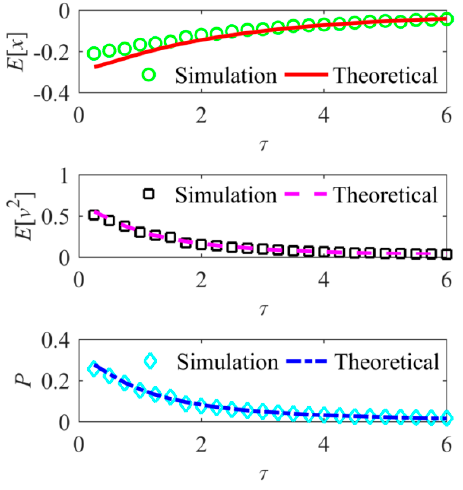
Figure 5. Influence of correlation time on the mean displacement, mean square voltage, and power output.